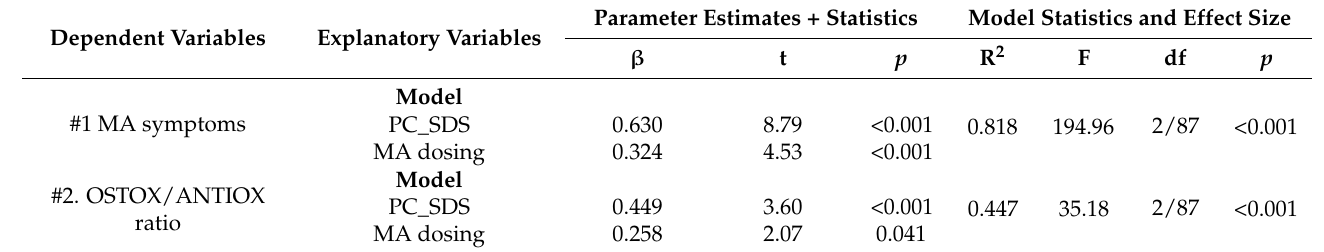
Table 6. The results of multiple regression analyses with methamphetamine (MA)-induced symp- toms and the oxidative stress toxicity/antioxidant defenses (OSTOX/ANTIOX) ratio as dependent variables and MA dependence and MA intake features as explanatory variables.